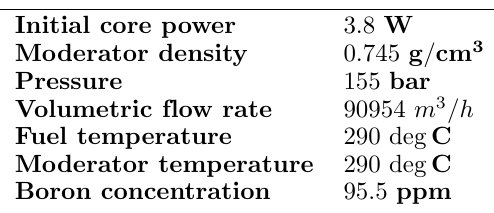
Table 1. HZP initial conditions of the PWR core.